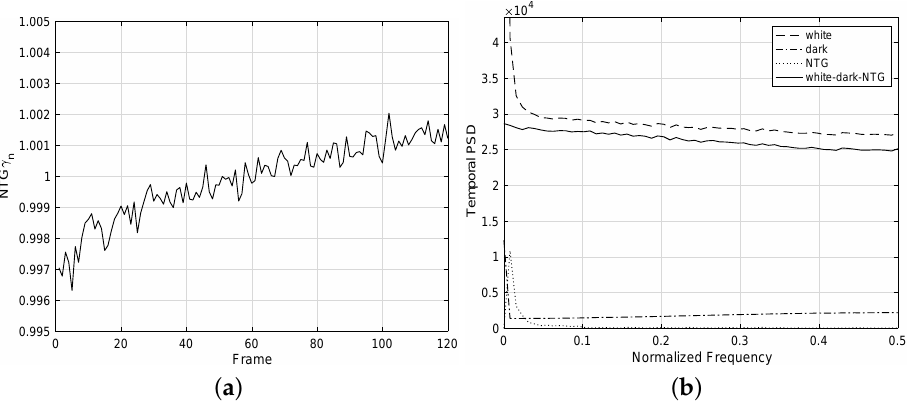
Figure 4. Example of NTG γ n (the frame rate is 10 fps, and the dose is 1809 nGy). ( a ) NTG curve of γ n with respect to the frame; ( b ) Temporal PSD curve of